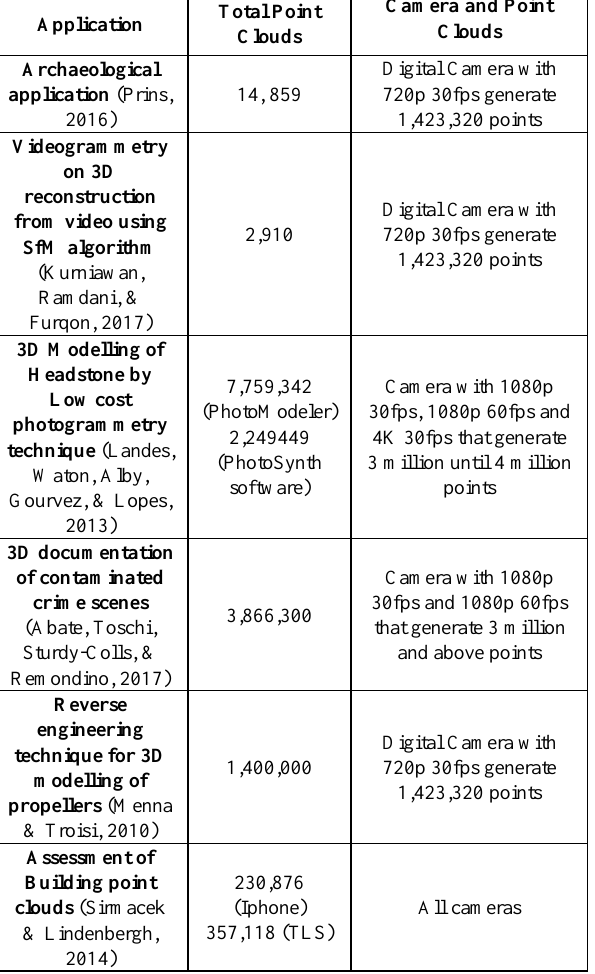
Table 8. Other application with total point clouds and camera specifications’ point